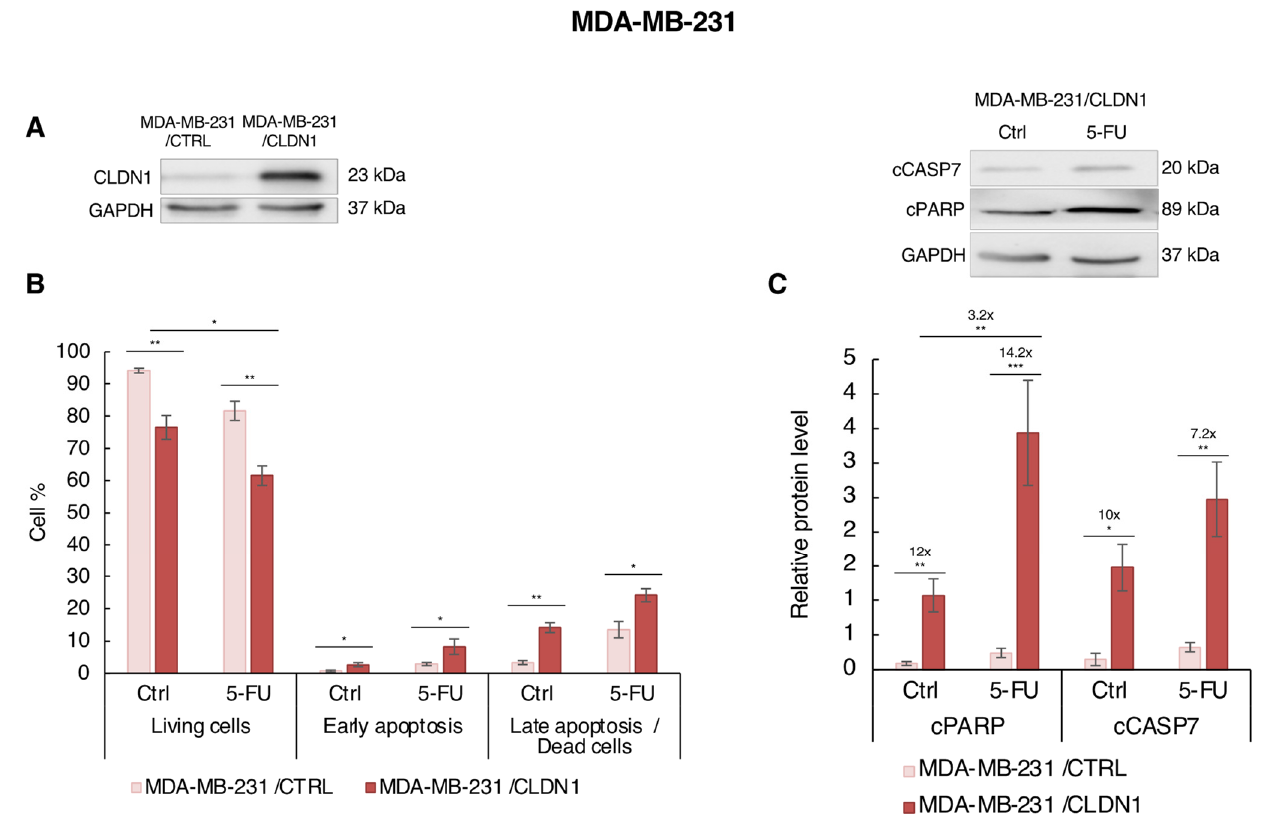
Figure 7. CLDN1 expression sensitizes MDA-MB-231 cells to 5-FU. MDA-MB-231 cells stably trans- fected with CLDN1 vector (MDA-MB-231/CLDN1) or the empty vector (MDA-MB-231/CTRL) were treated for 72 h with 5-FU at 50 µ M or with solvent (Ctrl). ( A ) CLDN1 expression was studied by western blot. ( B ) Cells were co-labeled with annexin V coupled to FITC and with propidium iodide and the living, early- and late-apoptotic cells were analyzed by flow cytometry. ( C ) Cleavage of apoptotic markers PARP-1 (cPARP) and caspase 7 (cCASP7) expressions were analyzed by Western blot. Relative protein level expressions correspond to the protein of interest on GAPDH ratios. The Western blot picture compared MDA-MB-231/CLDN1 non-treated cells (Ctrl) and 5 FU treated cells. The values represent the means ± SEM of three to four different experiments. A p -value of less than 0.05 was considered statistically significant with * p < 0.05, ** p < 0.01, *** p < 0.001. The uncropped blots are shown in File S1.